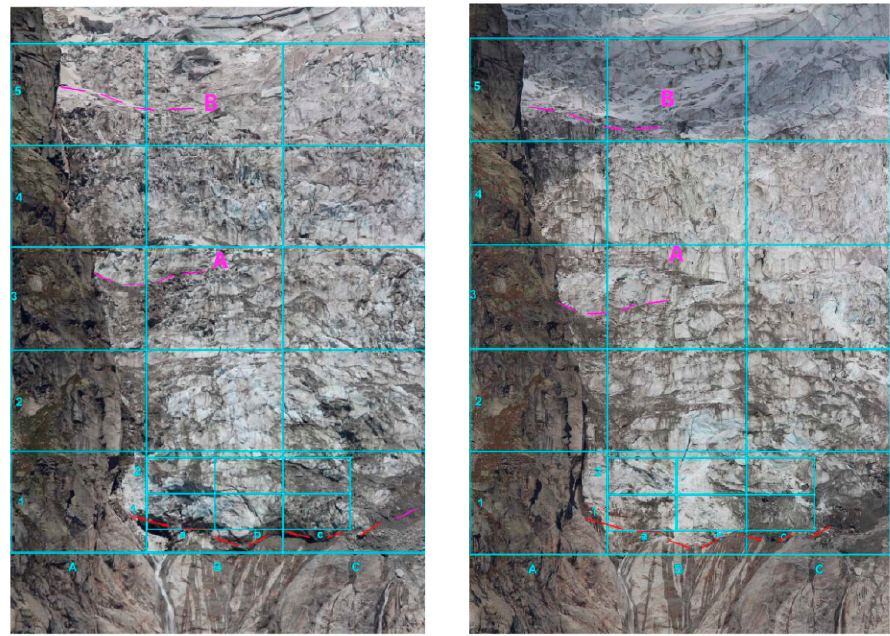
Figure 6. Visual analysis of the glacier flow on 2 August 2015 ( left ) and and 8 October 2015 ( right ). The superimposed grid simplifies the comparison between different areas. In particular the movement of the pattern highlighted by the letter A appears evident. The B pattern appears less changed.